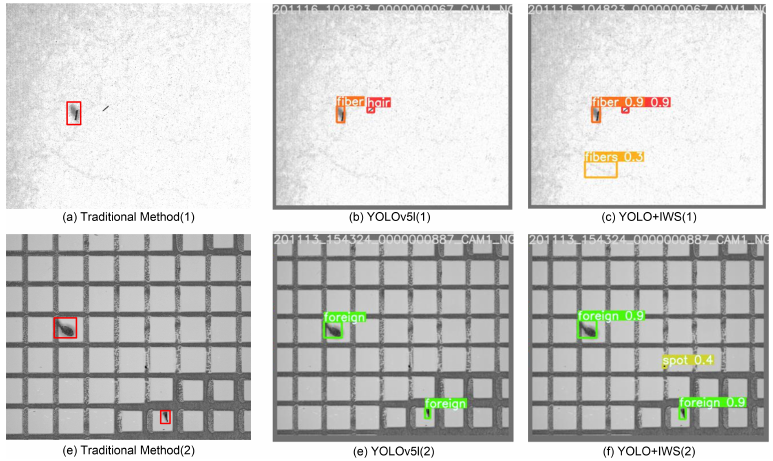
Figure 16. Visualization effect